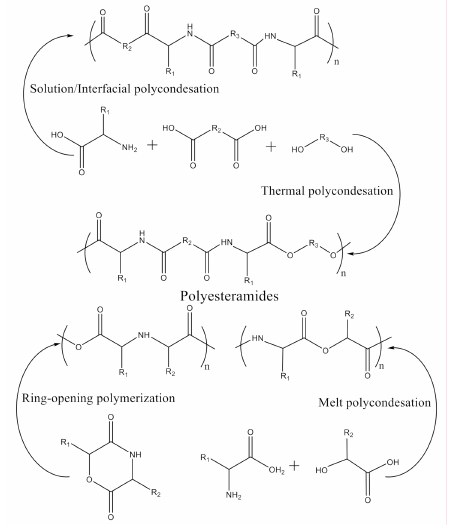
Figure 3. Pathways for polyesteramide